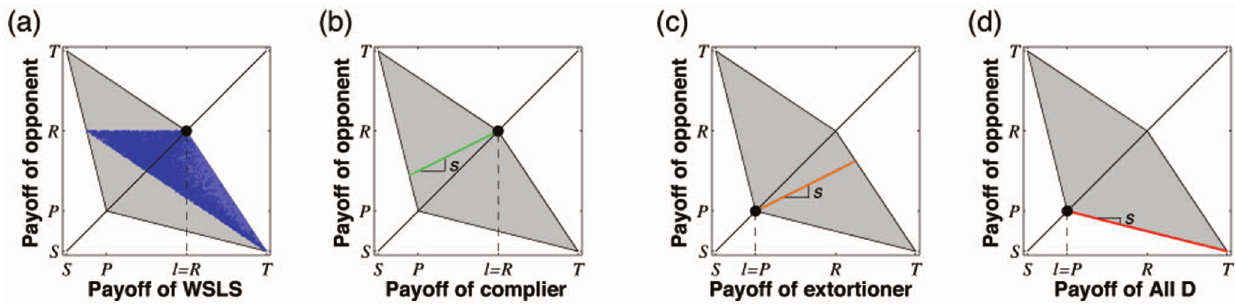
Figure 1. Illustration of zero-determinant strategies for an iterated prisoner’s dilemma with T ~ 5 , R ~ 3 , P ~ 1 and S ~ 0 . All graphs show the possible payoffs of the focal player (on the horizontal axis) and the resulting payoff for the opponent (on the vertical axis) as colored areas or lines. The colored points represent the payoff pairs for 10 3 randomly chosen opponents. (a) In general, as for example when the focal player applies the win-stay lose-shift strategy p ~ (1,0,0,1) , the possible payoff pairs form a convex polygon. (b) However, if the focal player applies a compliant strategy, the set of all possible payoff pairs degenerates to a line with positive slope s , which intersects the diagonal at l ~ R . (c) An extortioner enforces payoff relations that are on a line with positive slope s , intersecting the diagonal at l ~ P . (d) The strategy AllD ~ (0,0,0,0) enforces a linear relation between the payoffs of the two players although AllD is not a zero-determinant strategy for the given parameters, as described in the Methods section.